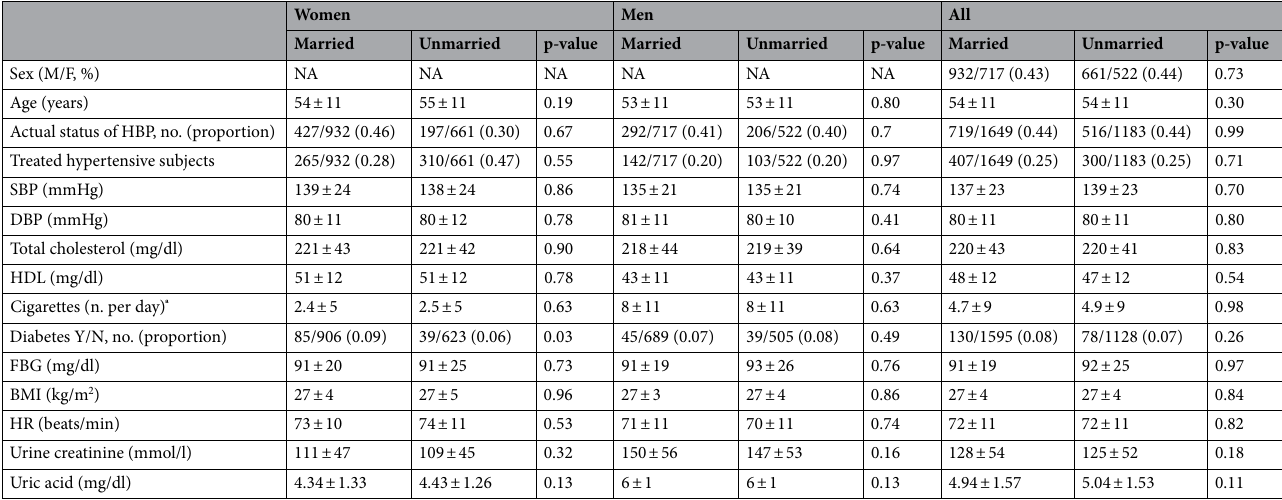
Table 1. Baseline values by sex and marital status in the participants in the Gubbio Population Study. BMI body mass index, DBP diastolic blood pressure, FBG fasting blood glucose, HDL high-density lipoprotein,